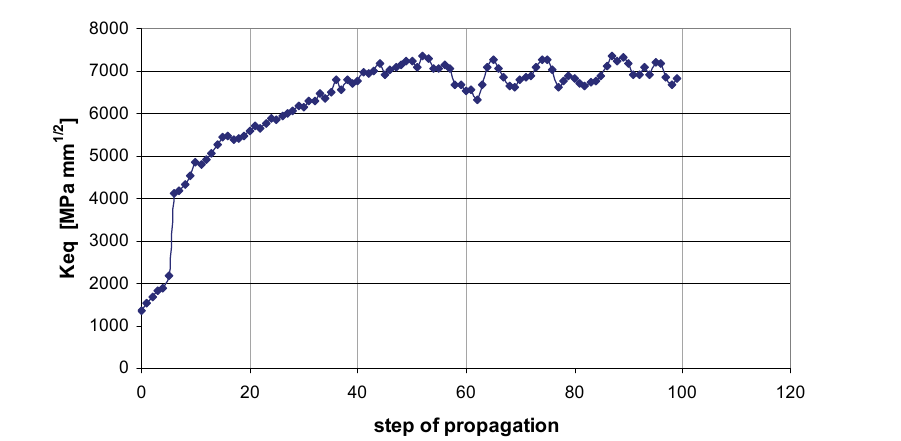
Figure 11: Relationship between equivalent stress intensity factor K eq and propagation step.